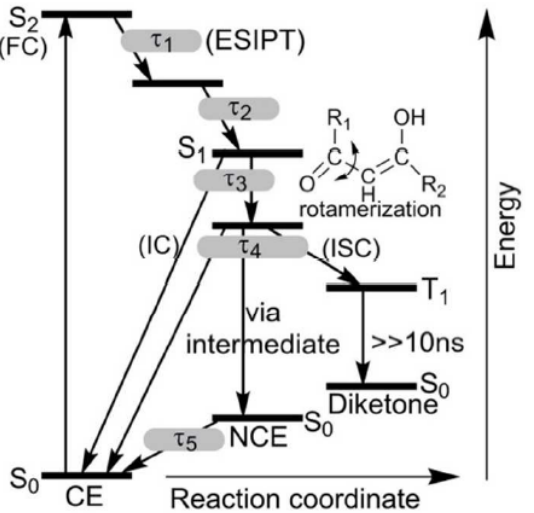
Figure 3. R 1 , R 2 , and R 3 can either be the substituent to the right or H. Ultrafast electron diffraction studies of acac showed that the chelate proton is clearly at one oxygen at the time in the electronic ground state, whereas it is at the center of the hydrogen bonded system in the excited state [53]. Vertical laser excitation of the p-p band (S 0 to S 2 ) leads to excited state intramolecular proton transfer (ESIPT). The process is more complex than simple ESIPT, as seen in Scheme 5.